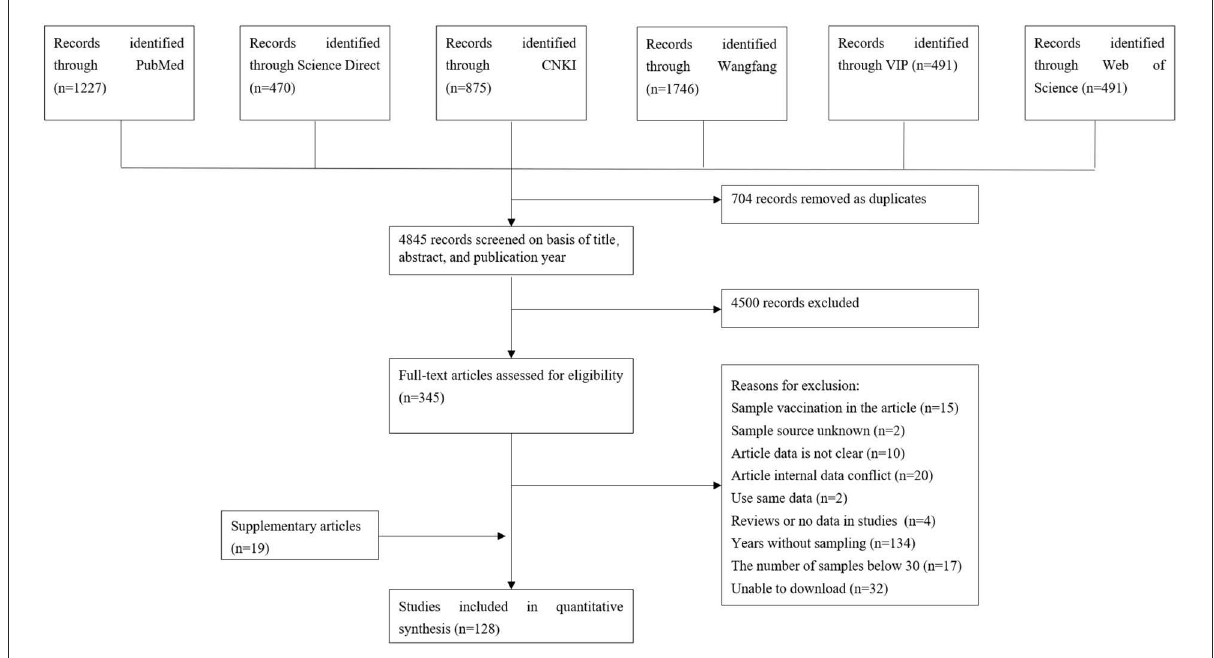
FIGURE1 Flow diagram of eligible studies for searching and